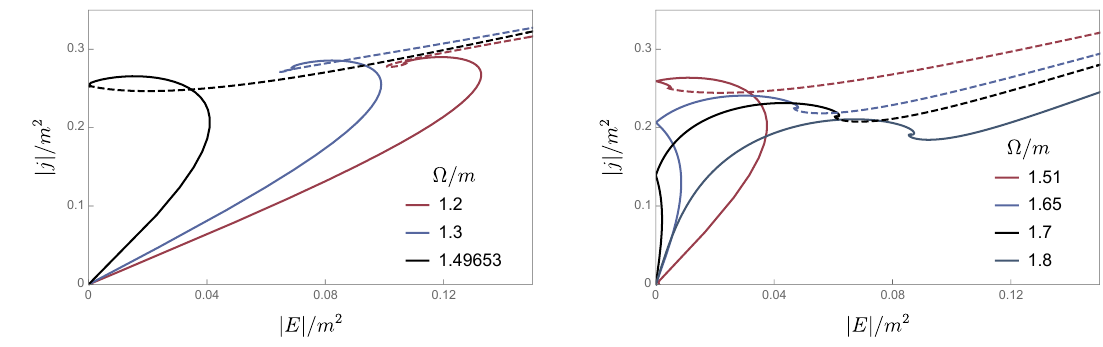
Figure 4 . Electric current versus electric (cid:12)eld for (cid:10) (cid:20) (cid:10) c (left) and (cid:10) > (cid:10) c (right) around the (cid:12)rst vector meson resonance. The solid curves correspond to the insulator (Minkowski) phase, whereas the dotted curves represent the conductive (black hole) phase. On the right curve we show that E can only vanish for j 6 = 0 for Minkowski embeddings with (cid:10) c = 1 : 4965 (cid:20) (cid:10) (cid:20) 1 : 732 = (cid:10) meson .